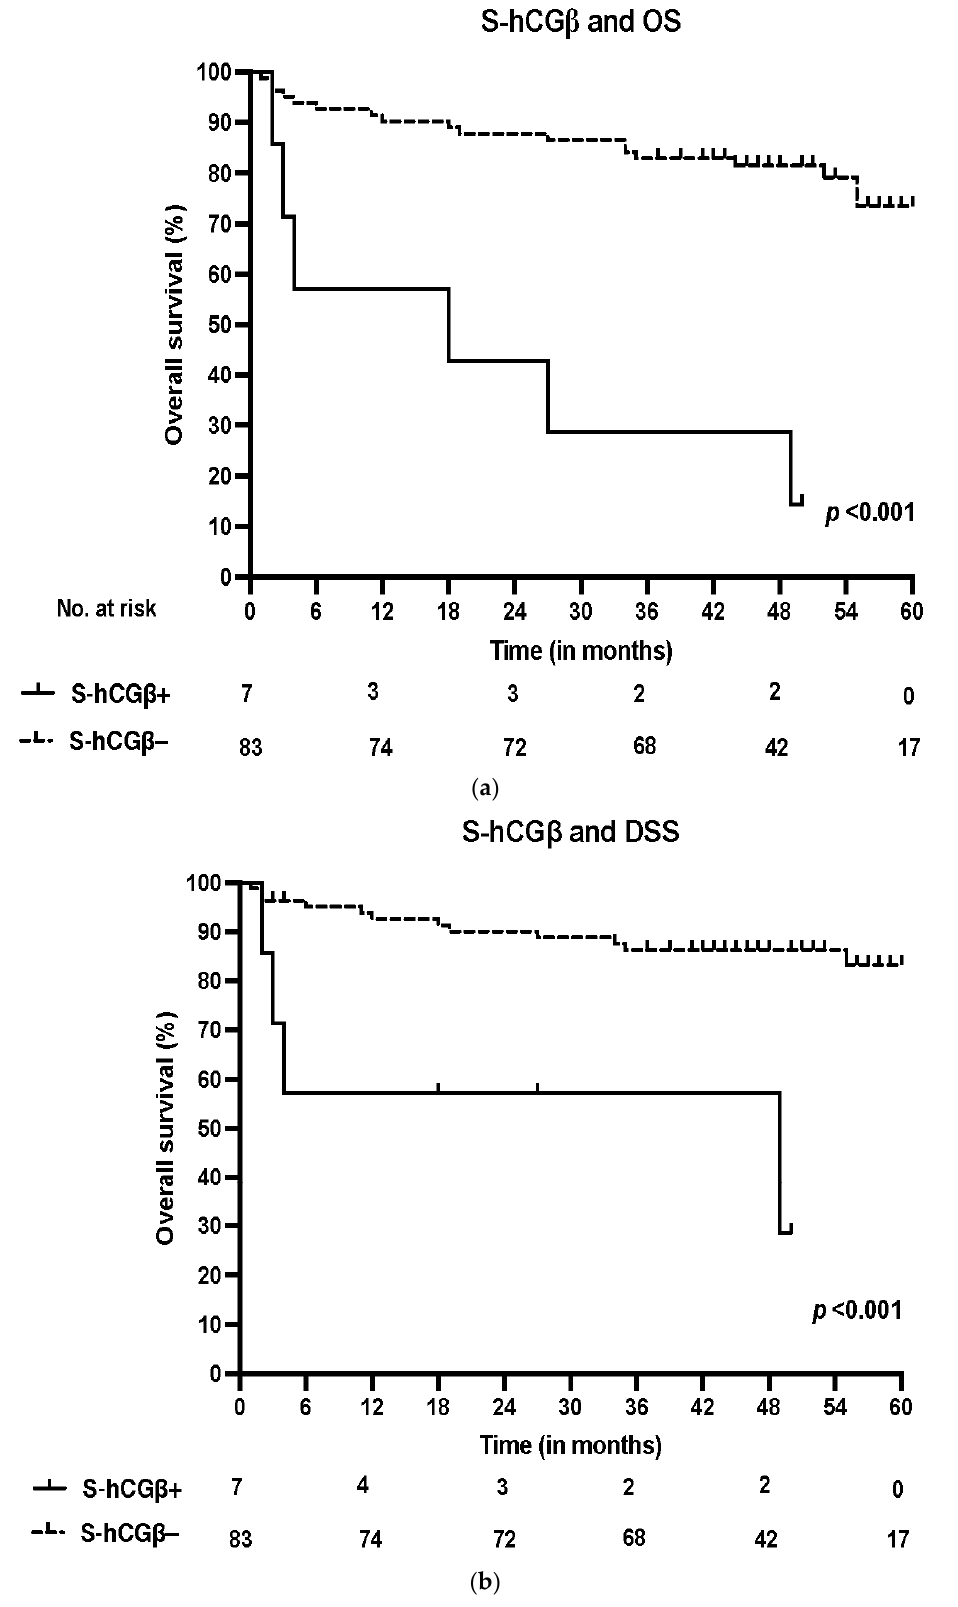
Figure 2. ( a ) Overall survival (OS) according to positive (>2 pmol/L) and negative (<2 pmol/L) S-hCG β in the whole patient cohort. ( b ) Disease-specific survival (DSS) according to positive and negative S-hCG β in the whole patient